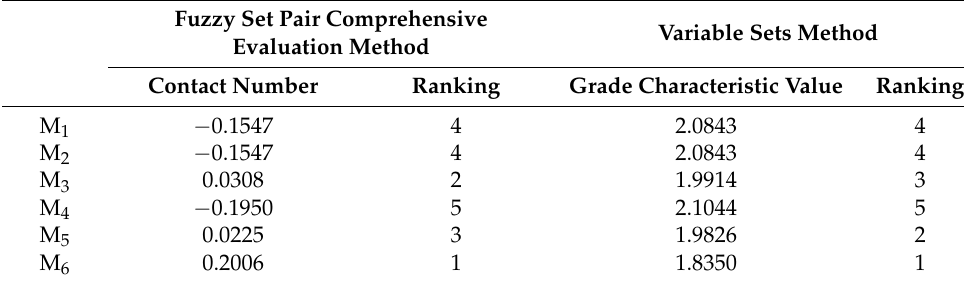
Table 5. Comparison with the result of the fuzzy sets method.